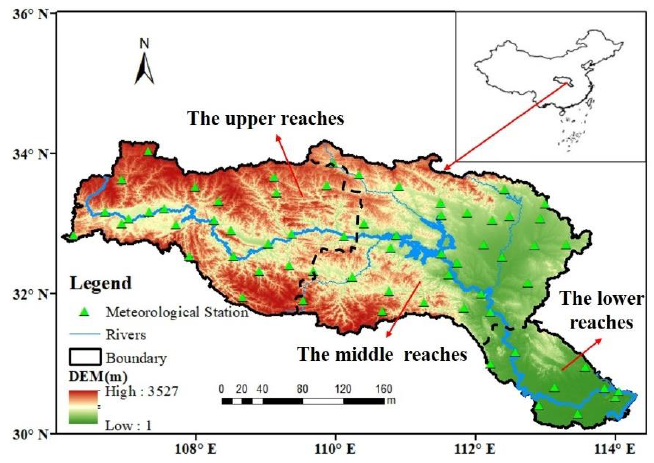
Figure 1. Location of the study area and the meteorological stations. Four level 3 SPPs and daily time series of 64 rain gauges between 2007 and 2018 were used in the GWR-LSTM model. The latest Version-7 TMPA products (TRMM 3B42-V7) and GPM IMERG Final Run V06B products were used. The two products were developed by the United States National Aeronautics and Space Administration (NASA) and the Japan Aerospace Exploration Agency (JAXA). Moreover, this study considered high- quality climate data (PERSIANN-CDR) and CMORPH products. The PERSIANN-CDR products were developed by the Center for Hydrometeorology and Remote Sensing (CHRS) using a PERSIANN algorithm. CMORPH products were developed by the Climate Prediction Center (CPC). Table 1 shows the basic information of the four SPP datasets used in this study. The rain-gauge observation data were collected from the China Meteorological Data Service Center (CMDC) (http://data.cma.cn/, accessed on 12 March 2020). The quality control techniques (such as extreme values check, internal